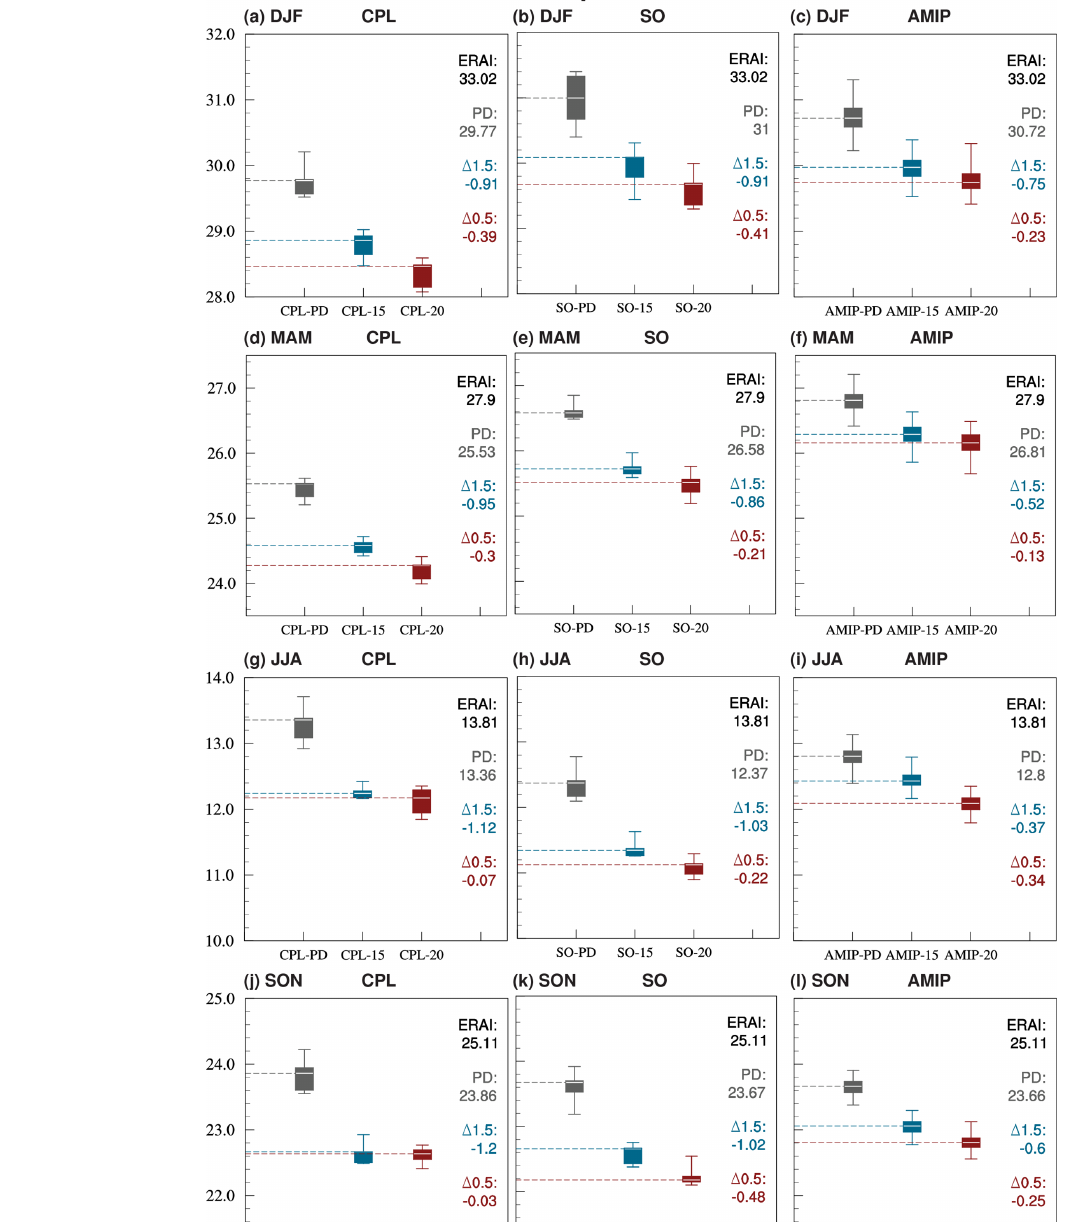
ima in the bandpass-filtered variance fields (e.g. Blackmon et al., 1977; Chang et al., 2002,